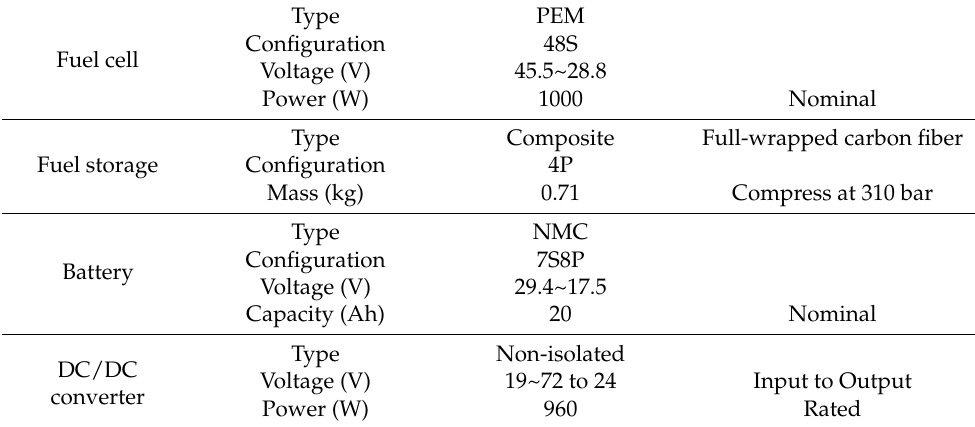
Table 3. Selected component